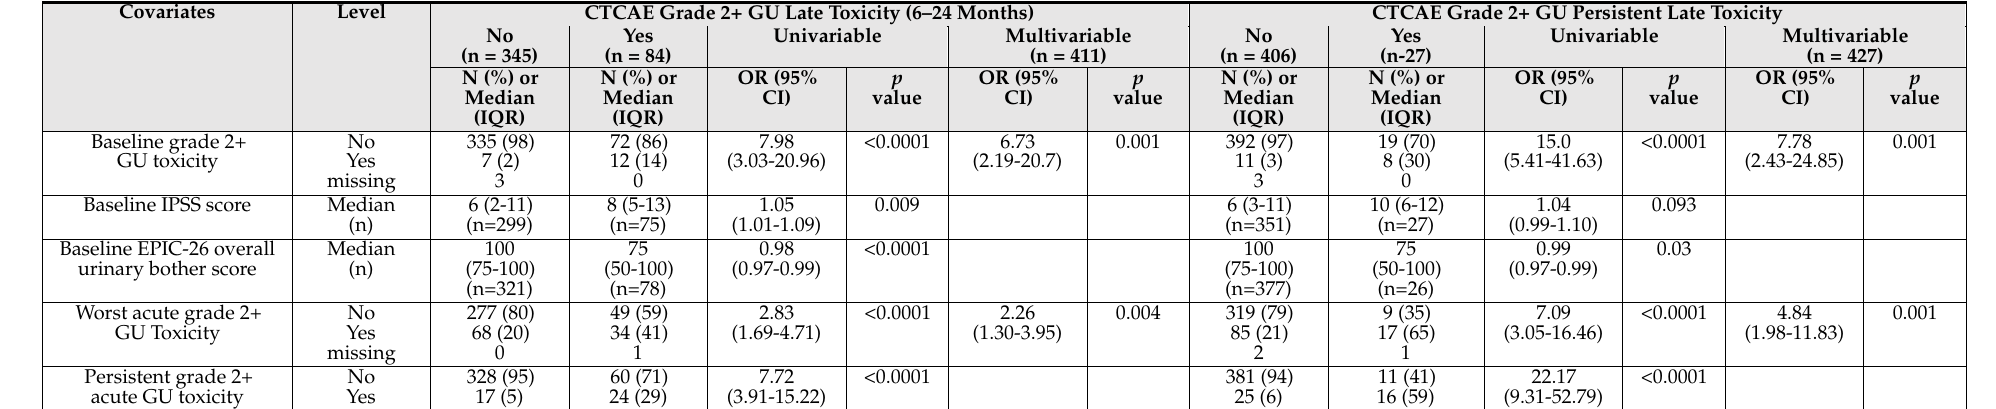
Table 3. Univariable and multivariable logistic regression model to identify covariates associated with late CTCAE genitourinary toxicity after